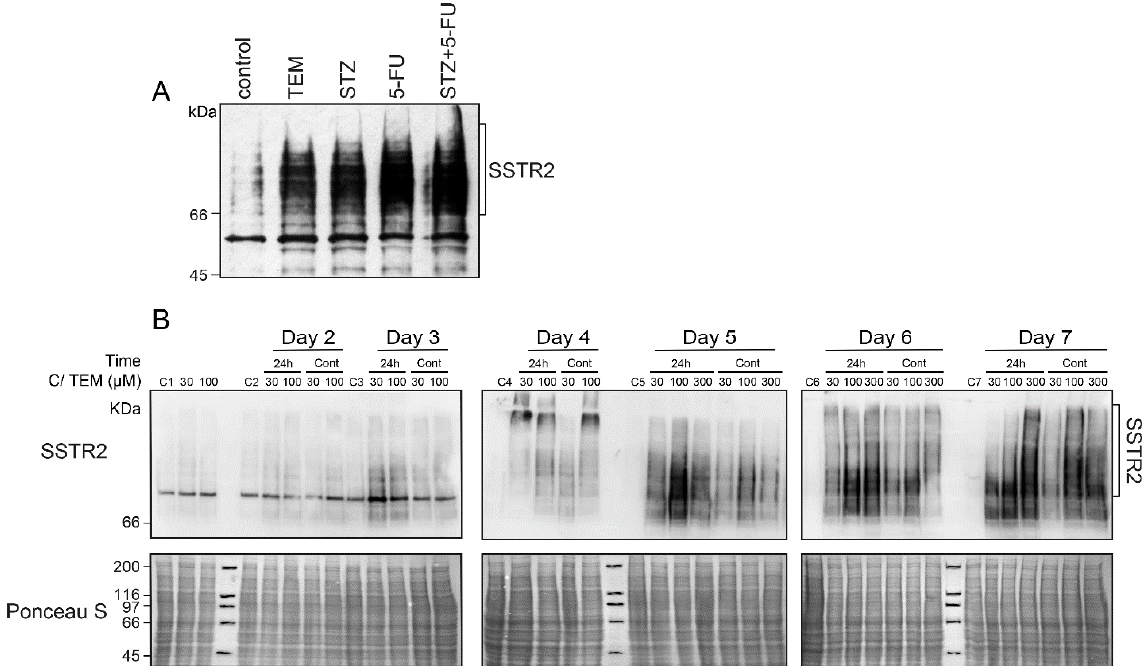
Figure 2. Effect of time and dose of TEM treatment on the time course of upregulation of SSTR2 in BON-1 cells. ( A ) Chemotherapy-induced upregulation of SSTR2 at five days in BON-1 cells. BON-1 cells treated with different drugs and LuTate for five days, as described in Figure 1A, were separately processed for immunoblotting for SSTR2. ( B ) TEM treatment time and dose-response on time-course of SSTR2 upregulation. BON-1 cells treated for 24 h (24 h lanes) or continuously for 5 days (Cont lanes) with specified doses of TEM or mock-treated controls (C-lanes) were harvested over 7 days for assessment of SSTR2 expression by immunoblotting. Ponceau S staining is shown as loading control. The blots shown here represent identical results obtained in at least two independent experiments for all the